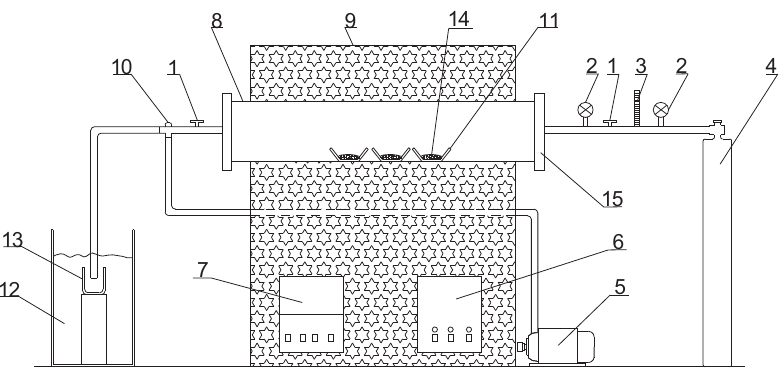
Figure 1: Horizontal tube box furnace ( SG - GL1700 ) : ( 1 ) thimble valve, ( 2 ) pressure gauge, ( 3 ) rotameter, ( 4 ) nitrogen bottle, ( 5 ) vacuum pump, ( 6 ) power control, ( 7 ) temperature control table, ( 8 ) corundum tube, ( 9 ) alumina fi ber, ( 10 ) triplet, ( 11 ) boat - like crucible, ( 12 ) water sink, ( 13 ) glass, and ( 14 ) slag and carbon.